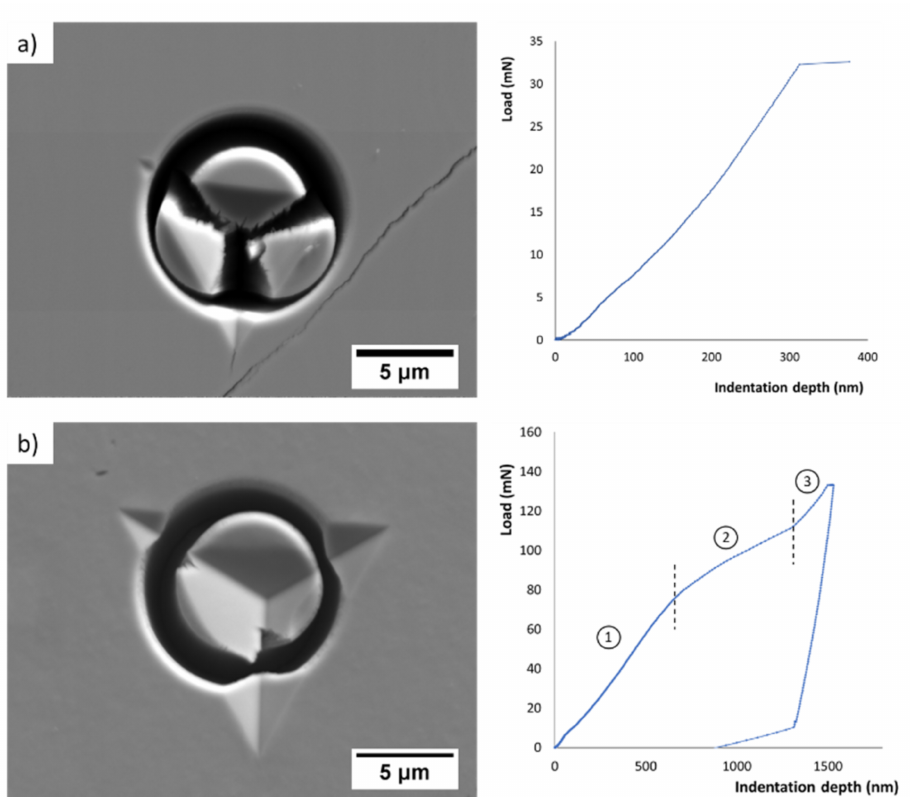
Figure 7. Example of a toughness test carried out on ( a ) trivalent and ( b ) hexavalent chromium deposits: SEM fractography of a pillar after failure and loading curve allowing the identification of the critical